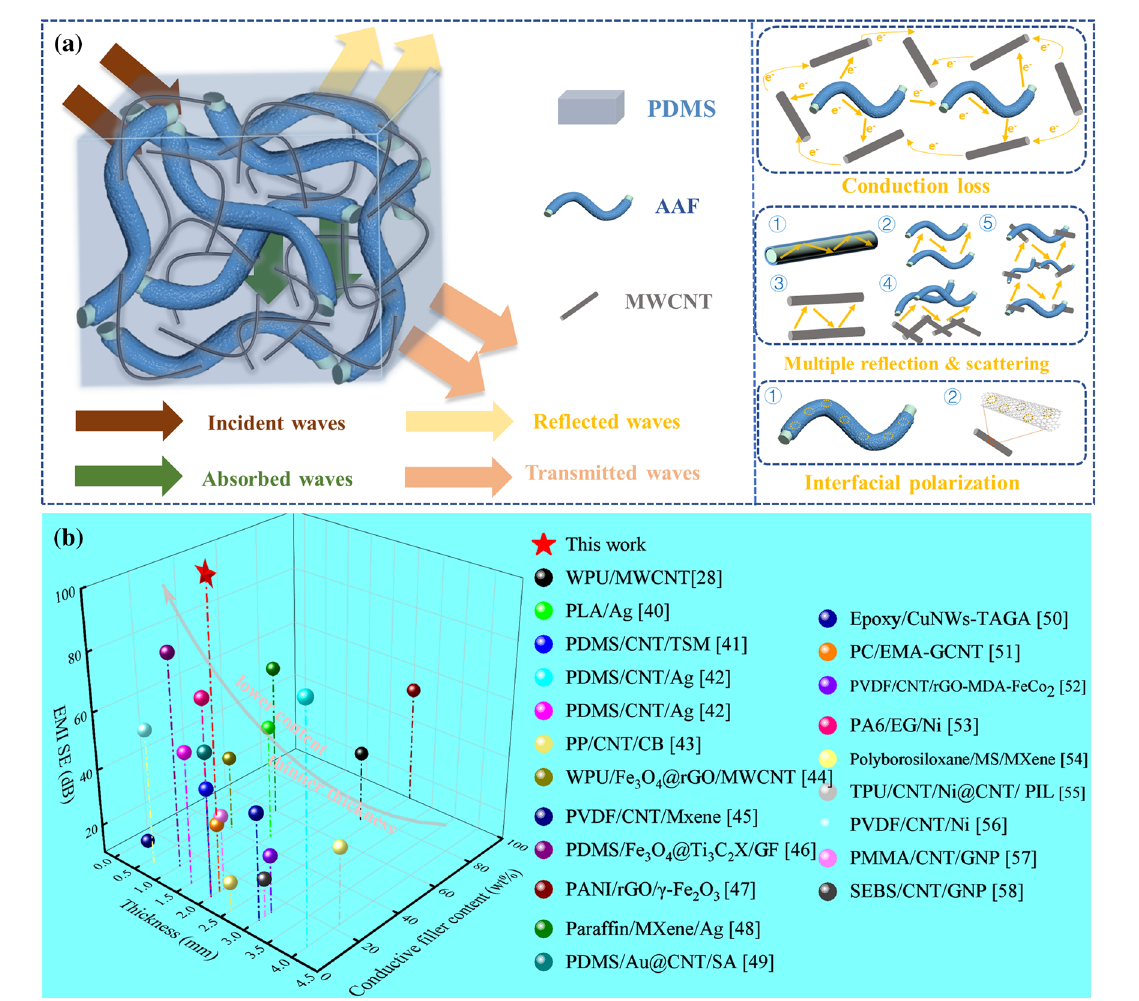
Fig. 5 a Schematic illustration of transmission loss of EM waves across the PAAC composite with the multi-scale conductive network; b Com- parison of EMI SE of PAAC composite and previously reported EMI shielding composites with different thicknesses and conductive filler con- tents. WPU, PLA, TSM, PP, CB, rGO, PVDF, MXene, GF, PANI, SA, CuNWs, TAGA, PC, EMA, GCNT, PA6, EG, MS, TPU, PIL, PMMA and SEBS represent waterborne polyurethane, poly(lactic acid), temperature-sensitive microspheres, polypropylene, carbon black, reduced